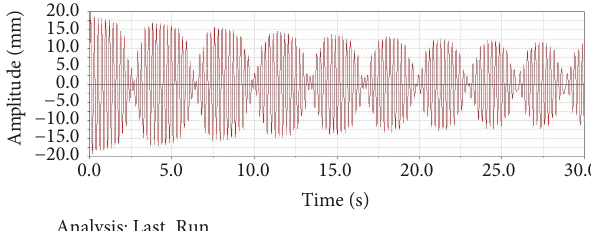
Figure 7: Vibration response of the flexible arm (no vibration absorber).